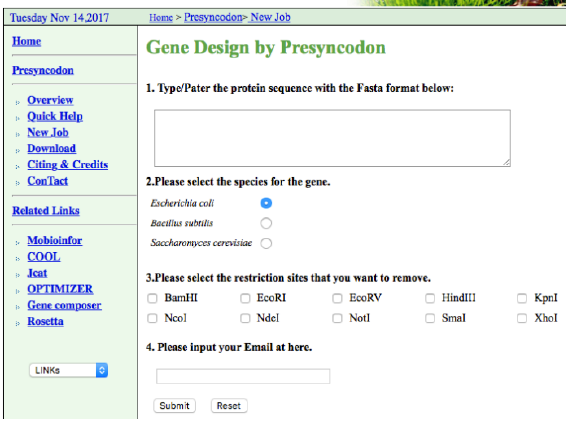
Figure 3. Screenshot of the web version of Presyncodon.